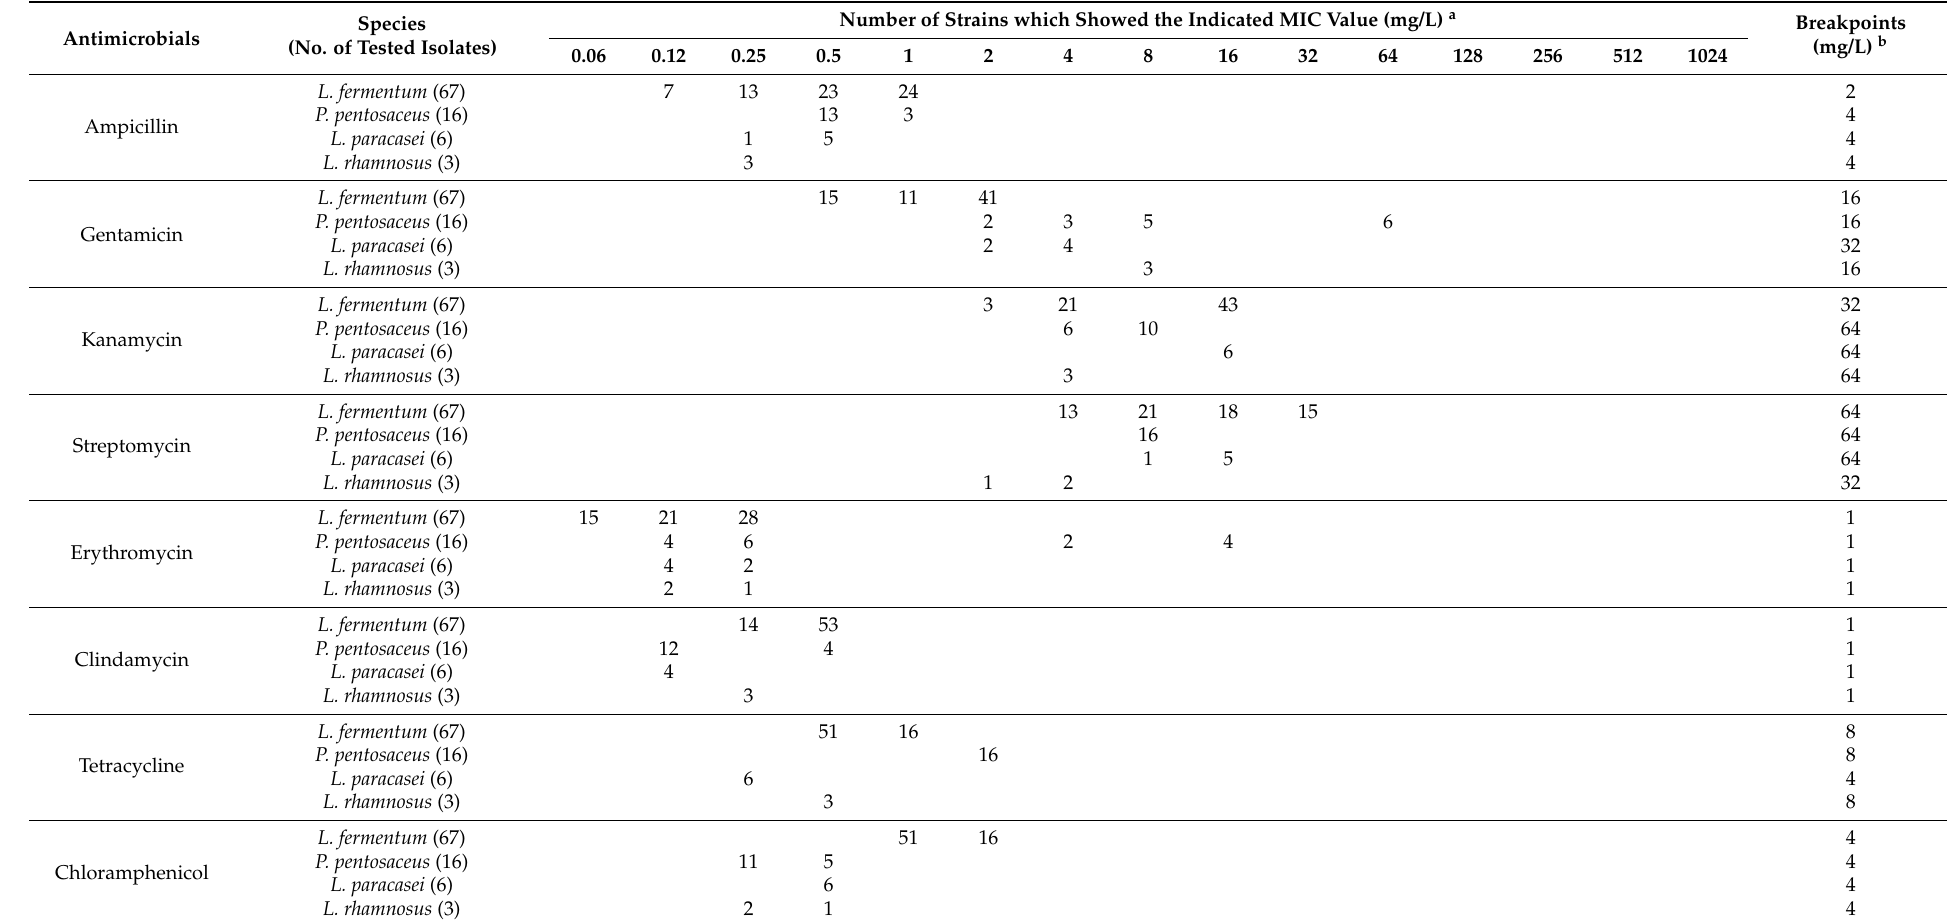
Number of Strains which Showed the Indicated MIC Value (mg/L) a Breakpoints